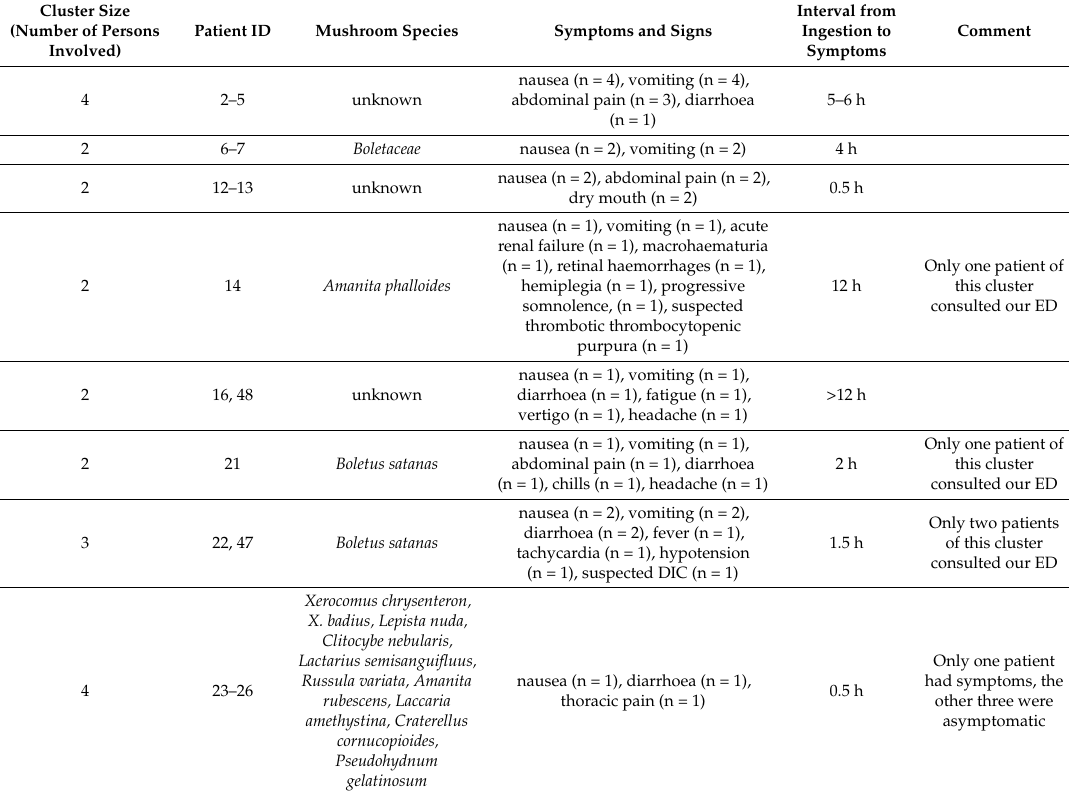
Table 4. Cases of group intoxication